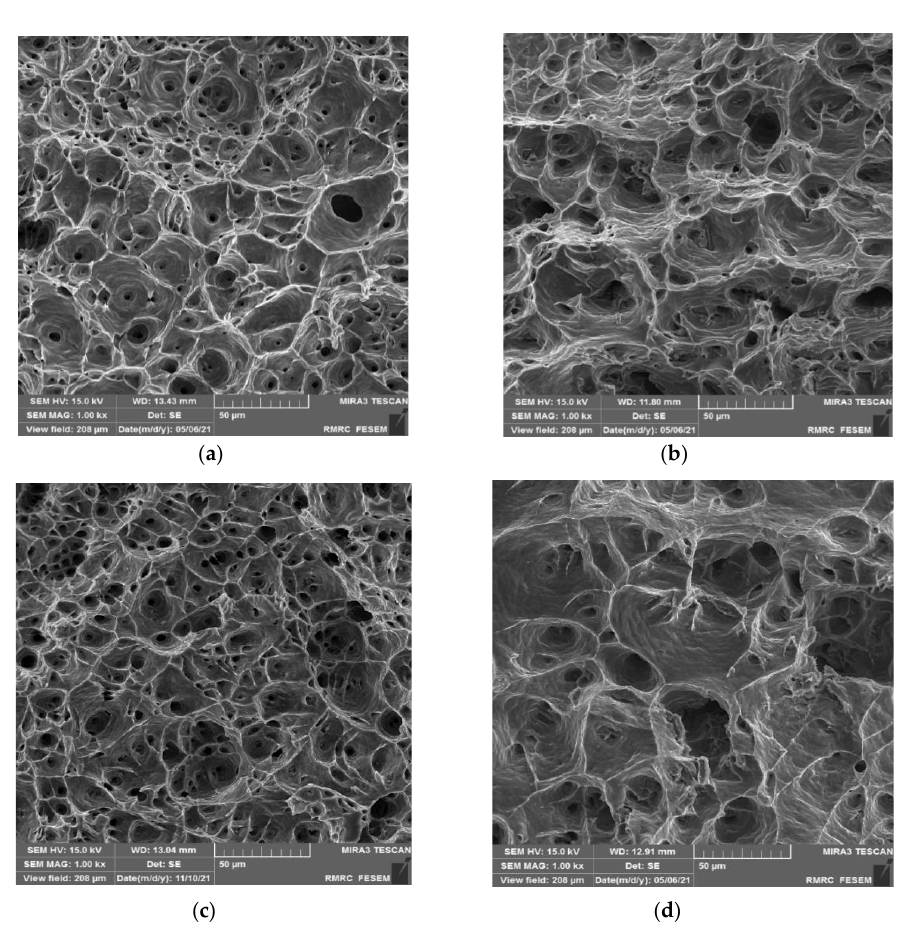
Figure 8. Fracture surface images of ( a ) Al 1350 at 20 °C, ( b ) Al – 0.5 wt% GNPs at 20 °C, ( c ) Al at 180°C, ( d ) Al – 0.5 wt% GNPs at 180 °C. 180 ◦ C, ( d ) Al–0.5 wt% GNPs at 180 ◦